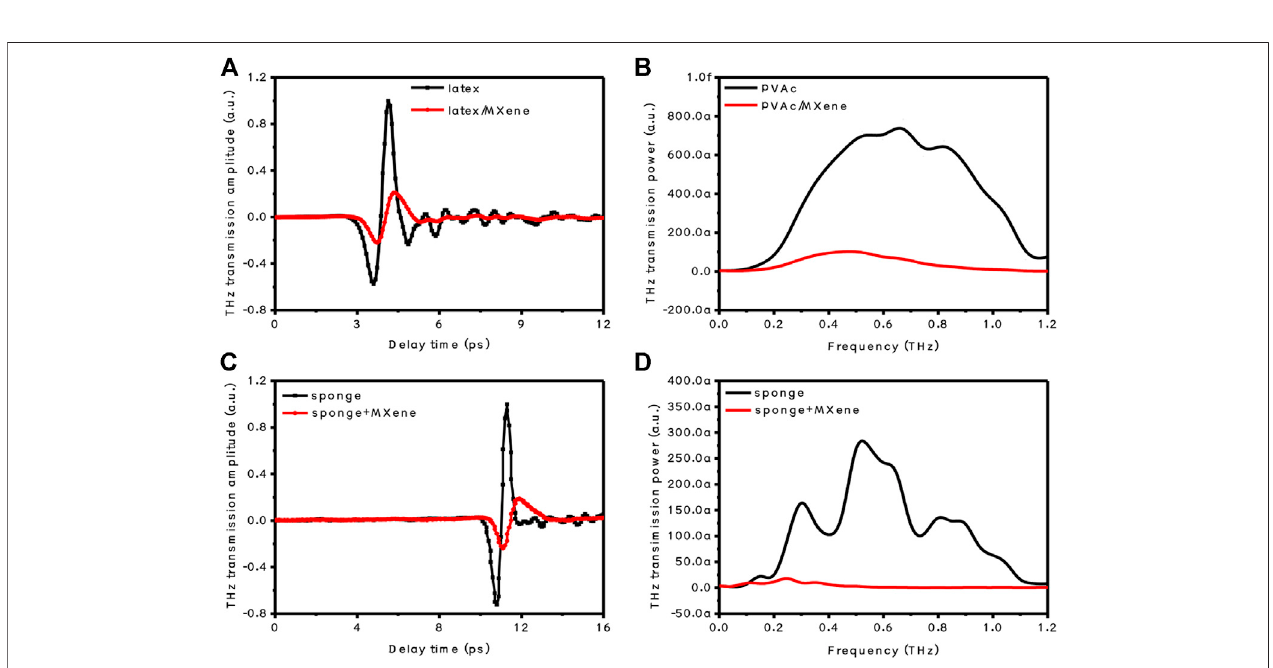
FIGURE 2 | (A) Terahertz time-domain spectra of samples with and without MXene coating on PVAc substrates. (B) Terahertz frequency-domain spectra of sampleswithandwithoutMXenecoatingonPVAcsubstrates. (C) Terahertztime-domainspectraofsampleswithandwithoutMXenecoatingonspongesubstrates. (D) Terahertz frequency-domain spectra of samples with and without MXene coating on sponge substrate.